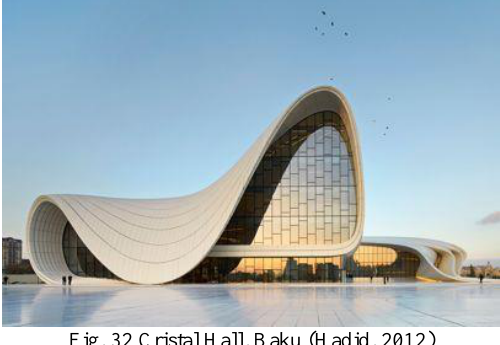
Fig. 32 Cristal Hall, Baku (Hadid, 2012)